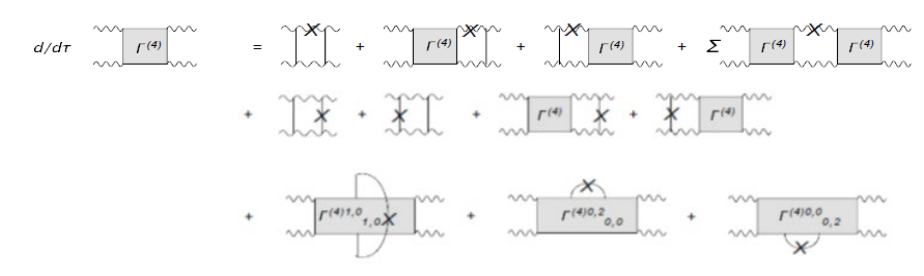
Fig. 2. k-derivative of the BFKL ladder. The crosses on internal lines denote the k derivative. The dots denote the momentum factors of the vertices.